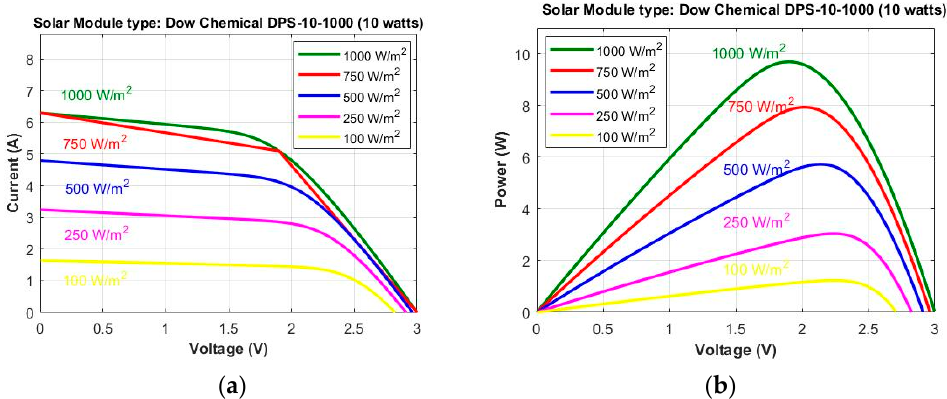
Figure 4. Solar Panel characteristics with variations in Irradiance level (Watts/m 2 ). ( a ) I–V Characteristics; ( b ) P–V Characteristics.